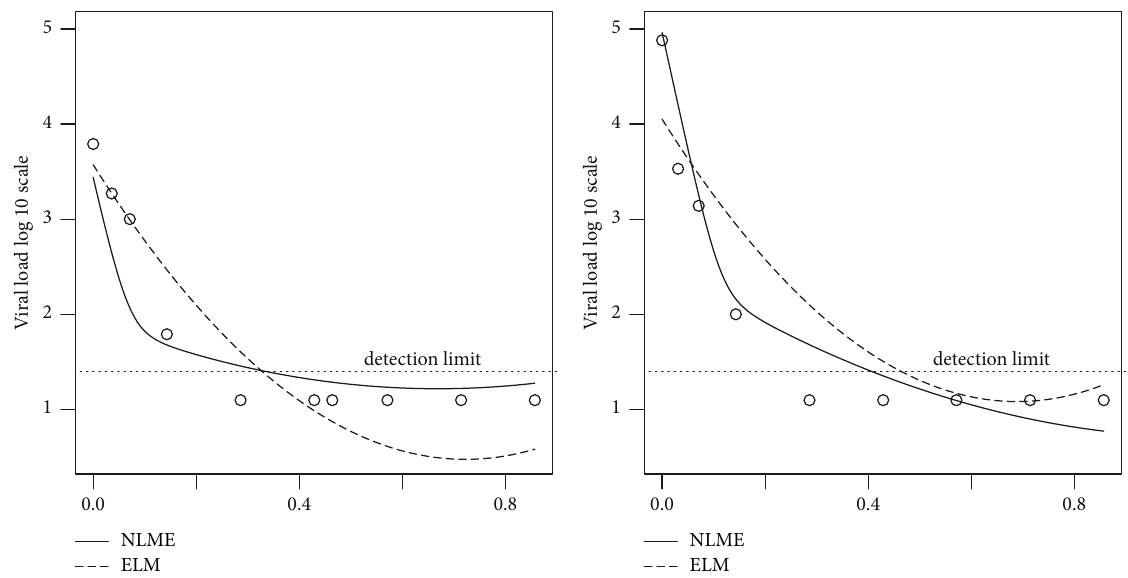
Figure 1: Fitted viral load curves for two randomly selected subjects. The open circles are the observed viral loads (the censored values are replaced by half the detection limit in log 10 scale for simplicity). The solid line is the fitted curve based on the NLME model, while the dashed line is fitted curve based on the ELM model. Table 1: Parameter estimates of the CD4 response model, based on the NLME and ELM covariate models respectively. NLME covariate model ELM covariate model Response model parameter Estimate SE